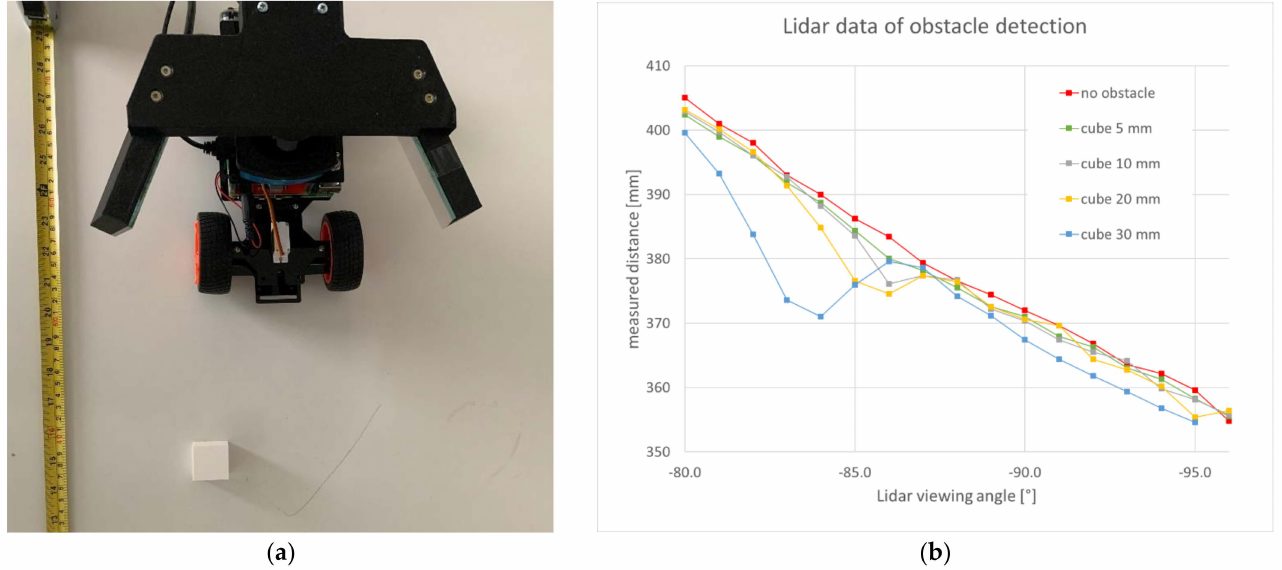
Figure 6. ( a ) Measurement setup with a cubical obstacle placed in front of the prototype vehicle. The Lidar setup with two mirrors acquires distance data in this setup to check what sizes of obstacles can be reliably detected. The presented setup is also a typical example for obstacles that severely threaten the prototype vehicle and keep it from driving on, if not detected and avoided. ( b ) Measurement data: Lidar distance raw values over Lidar rotation position for several sizes of cube obstacles in front of the prototype